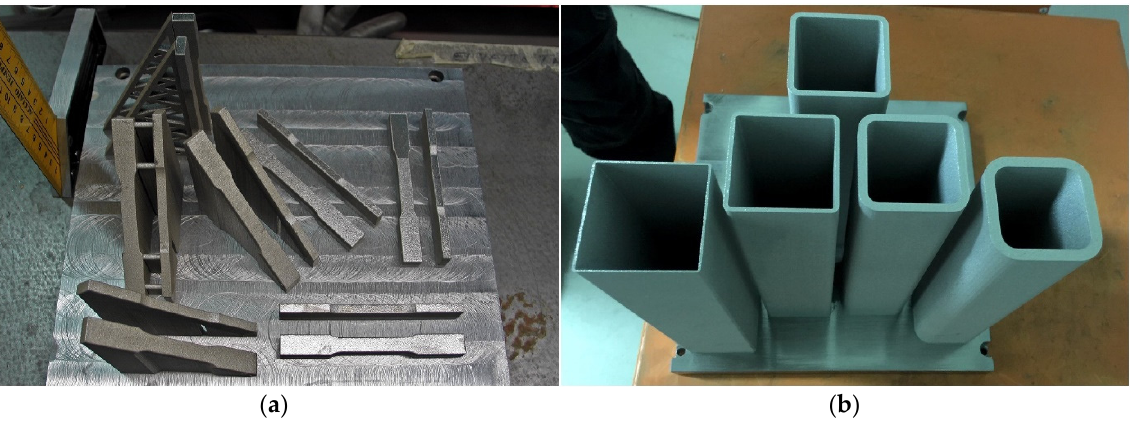
Figure 7. Printed Components for PBF Testing [5]: ( a ) PH1 specimens for tensile testing ( b ) 316L stub columns for compression testing. Reprinted with permission from ref. [5]. Copyright 2017 Copyright Elsevier Ltd.